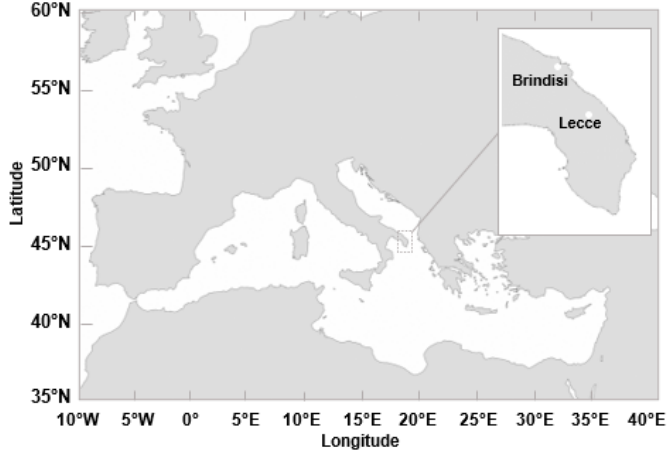
Figure 1. Geographical location of the study area in the Central Mediterranean basin. The location of the pollen monitoring sites both in Brindisi and in Lecce is shown by full dots in the insert.